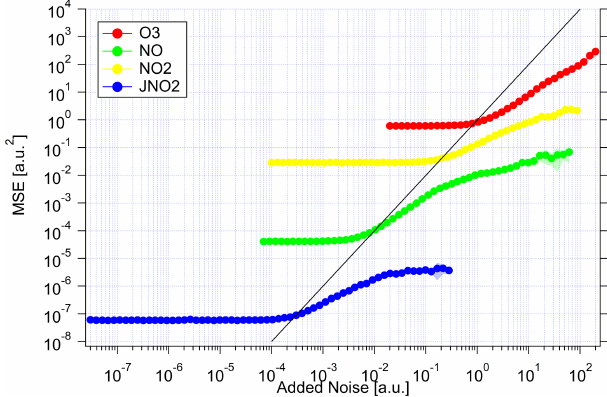
Figure 4. Example result of the SMC method used for de-noising: NO 2 mixing ratio as a function of time (UTC) for an arbitrary day of the field campaign. Original measurement (black), measurement with artificial noise (blue), PSS calculation (yellow), SMC ensem- ble mean (red) and ± 1 σ interval (shaded gray region). Algorithm 1 is applied again to the noised datasets to ob-